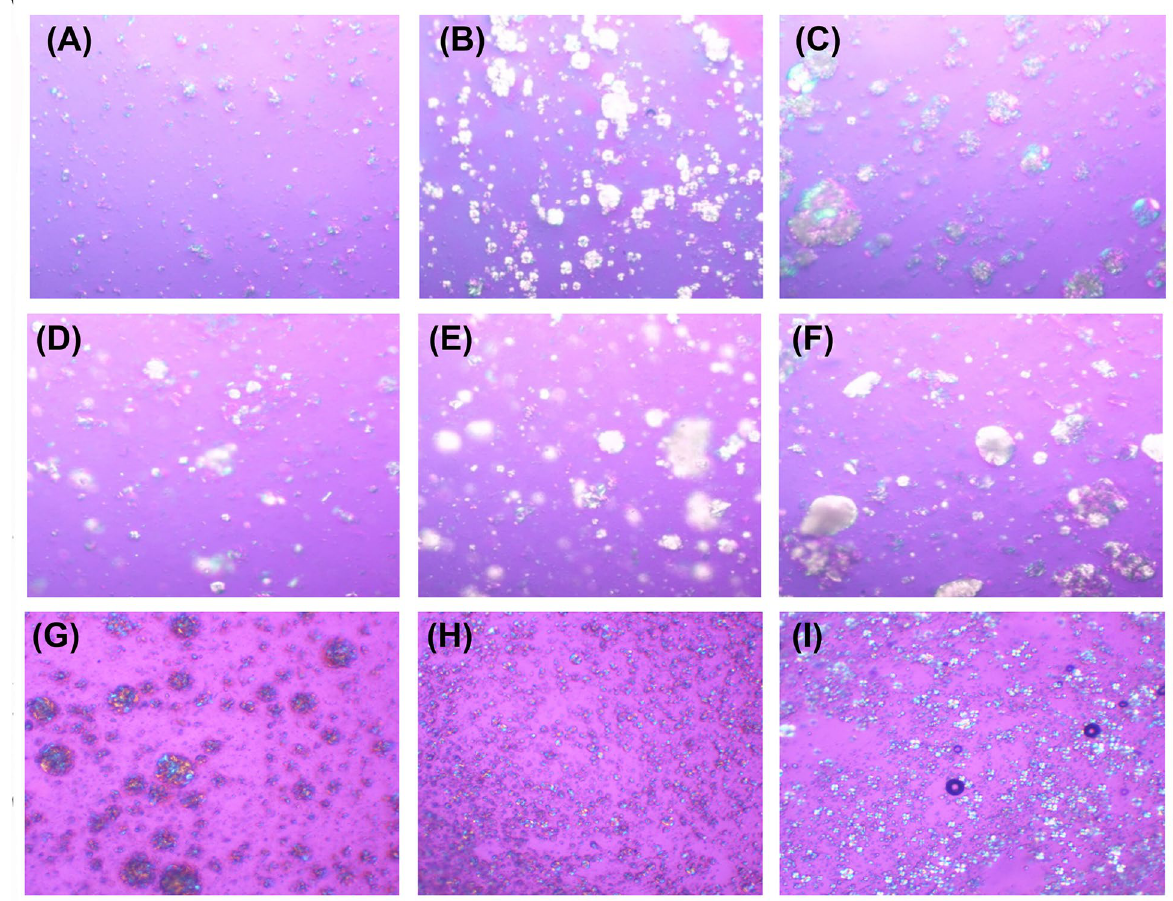
Figure 6. Liquid crystal formation under polarized light optical microscope (magnification 10×) of formulation containing xanthan gum with the concentration of 0.1% w / w ( A ), 0.5% w / w ( B ), and 1% w / w ( C ), Carbopol® U21 with the concentration of 0.1% w / w ( D ), 0.5% w / w ( E ), and 1% w / w ( F ), and sodium carboxymethylcellulose (SCMC) with the concentration of 0.5% w / w ( G ), 1% w / w ( H ), and 2% w / w ( I ).